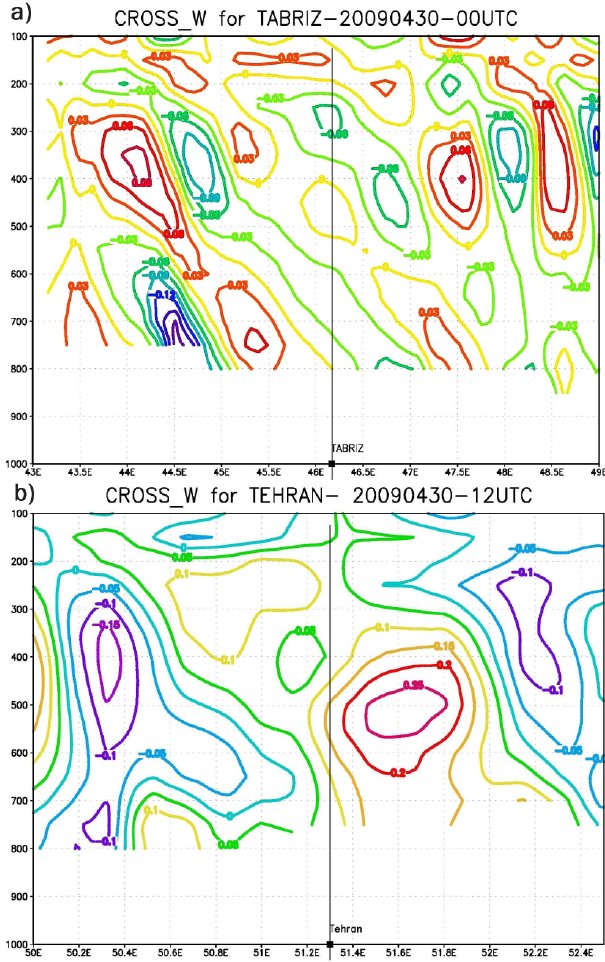
Fig. 9. (a) Vertical cross-section of vertical velocity (ms − 1 ), on 30 April 2009 for Tabriz station. (b) Vertical cross-section of verti- cal velocity (ms − 1 ), on 30 April 2009 for Tehran. 12 h (00:00 UTC to 12:00 UTC) is between 0 and − 3